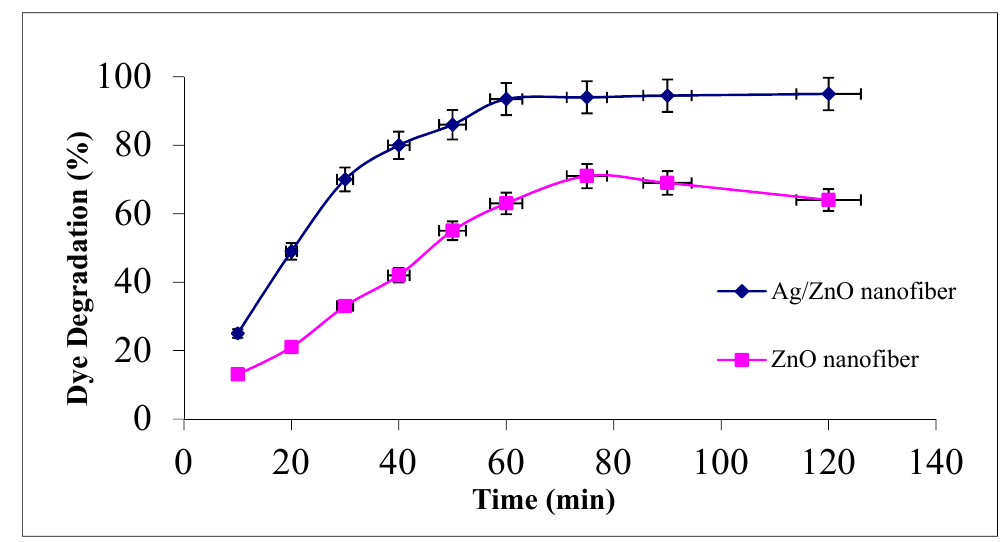
Figure 6. Effect of contact time on MG dye photocatalytic degradation process using ZnO polymeric nanofiber after and before silver immobilization (initial dye concentration = 20 ppm, nanofiber dose = 0.1 g, pH = 7 at room temperature).